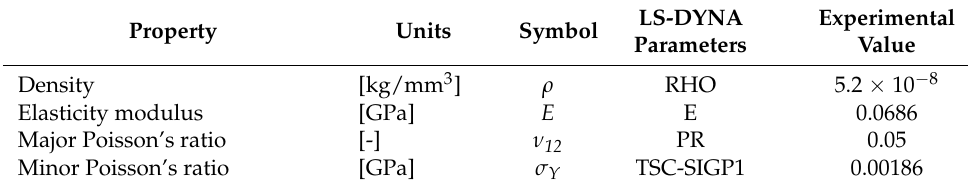
Figure 3. Sample dimension and SGs position [mm]. Table 2. Material properties of Rohacell 51 Table 1. Stiffness material properties of M40J/epoxy as published in Frulla et al. (*) [2] and associated strength material threshold [14].